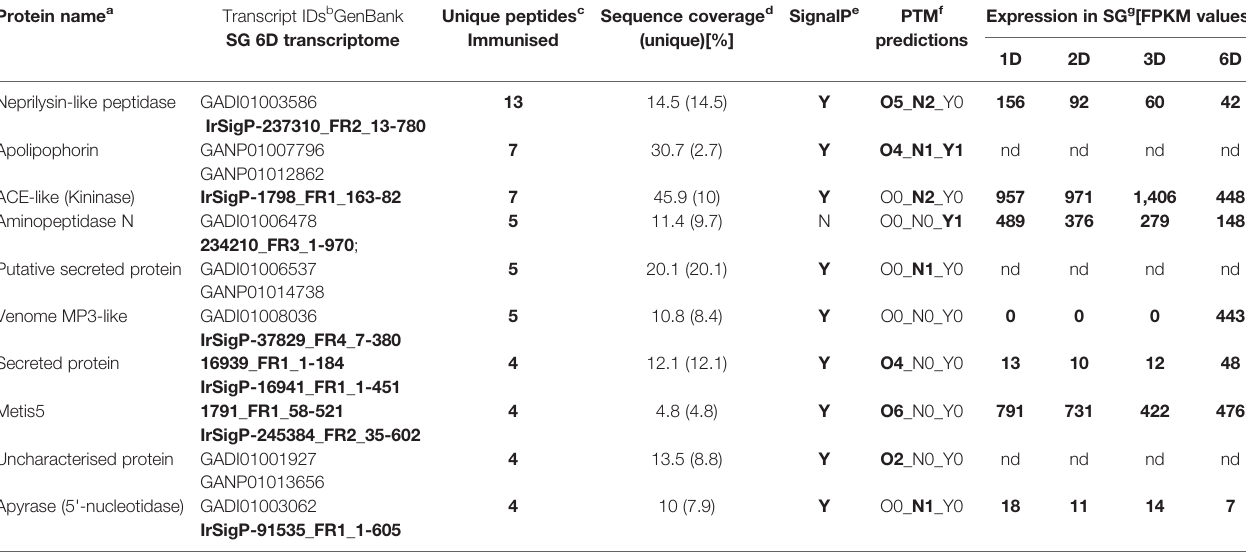
TABLE 1 | Identi fi cation and characterization of tick I. ricinus salivary antigens. Protein name a